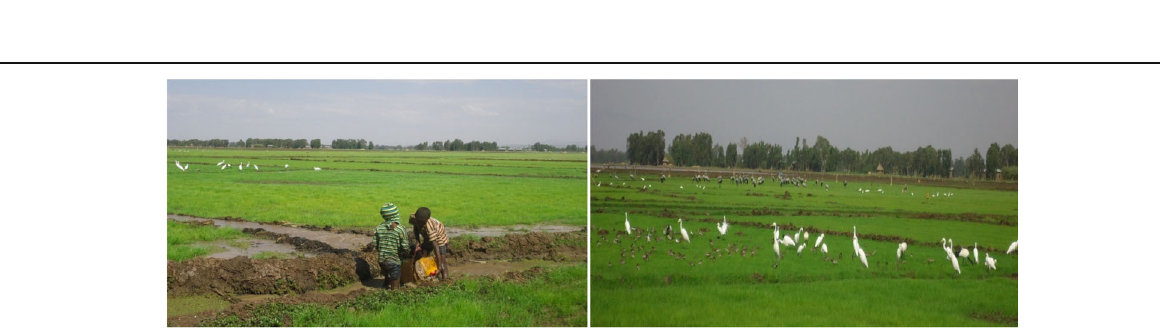
Fig. 9 Practice of small scale irrigation in the wetlands of Fogera and birds ’